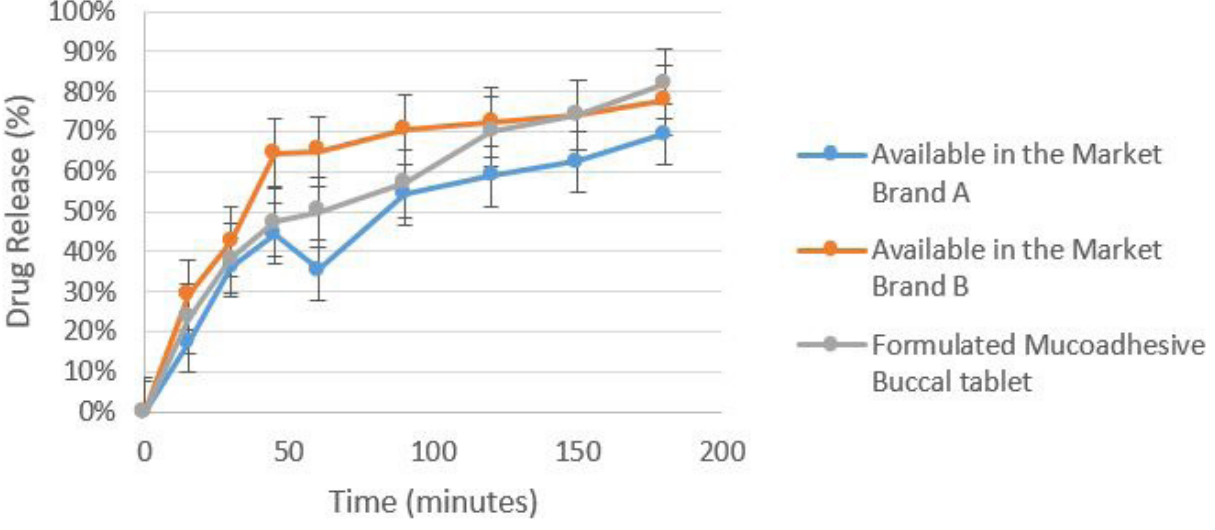
FIGURE 12 - Drug release graph of mefenamic acid (250 mg) products available in market and the formulated mefenamic acid (250 mg) mucoadhesive buccal tablet.